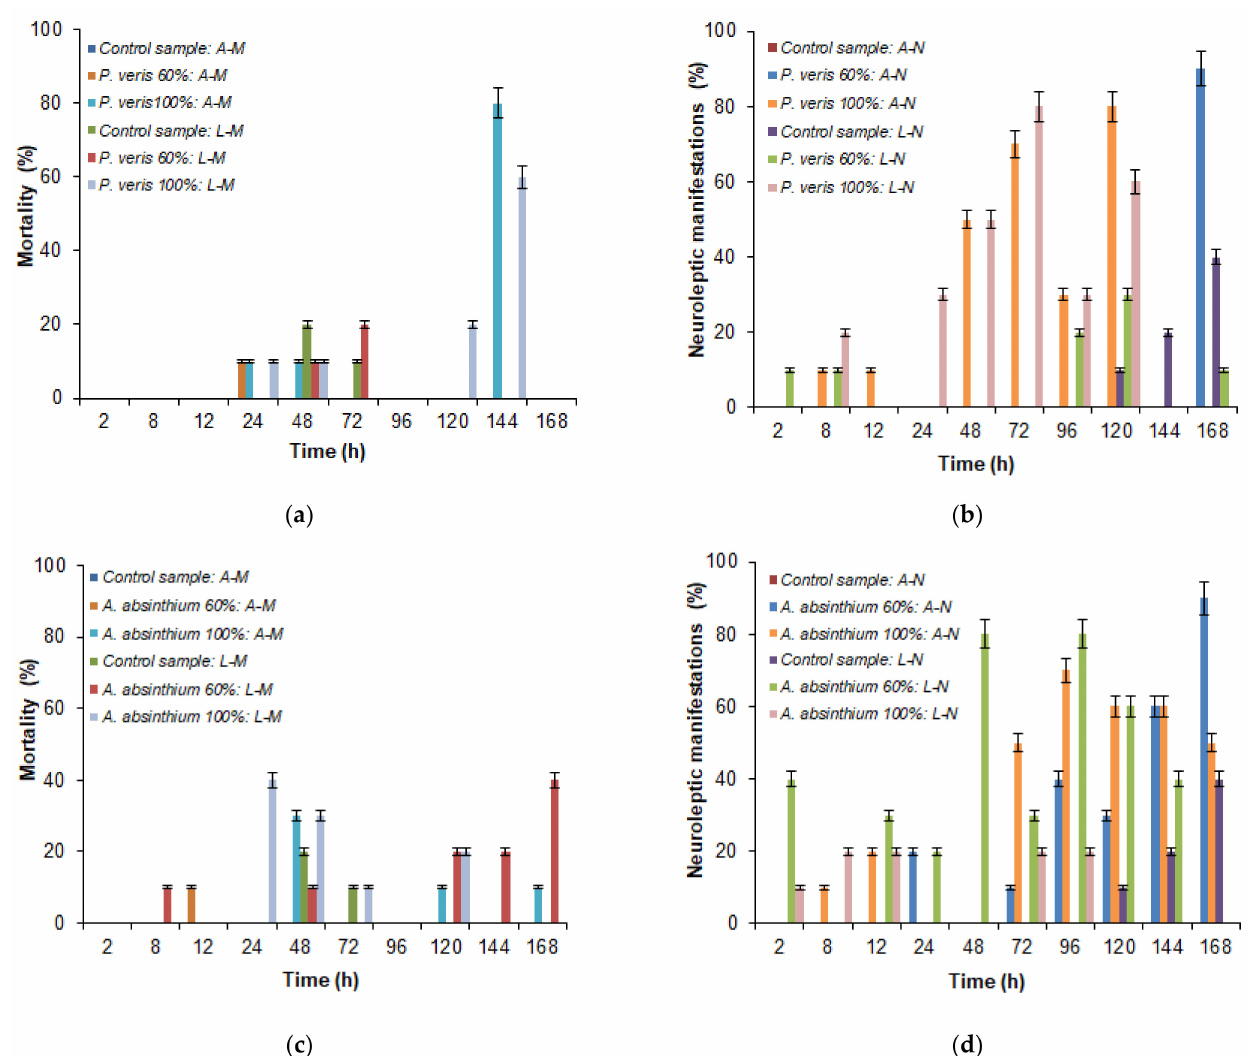
Figure 4. The results of the action of Primula veris ( a , b ) and Artemisia absinthium ( c , d ) plant extracts on a population of individuals belonging to Leptinotarsa decemlineata species (adults, larvae) (A–M: adults mortality; L–M: larvae mortality; A–N: adults neuroleptic manifestations; L–N: larvae neuroleptic manifestations). The columns error bars are mean ±